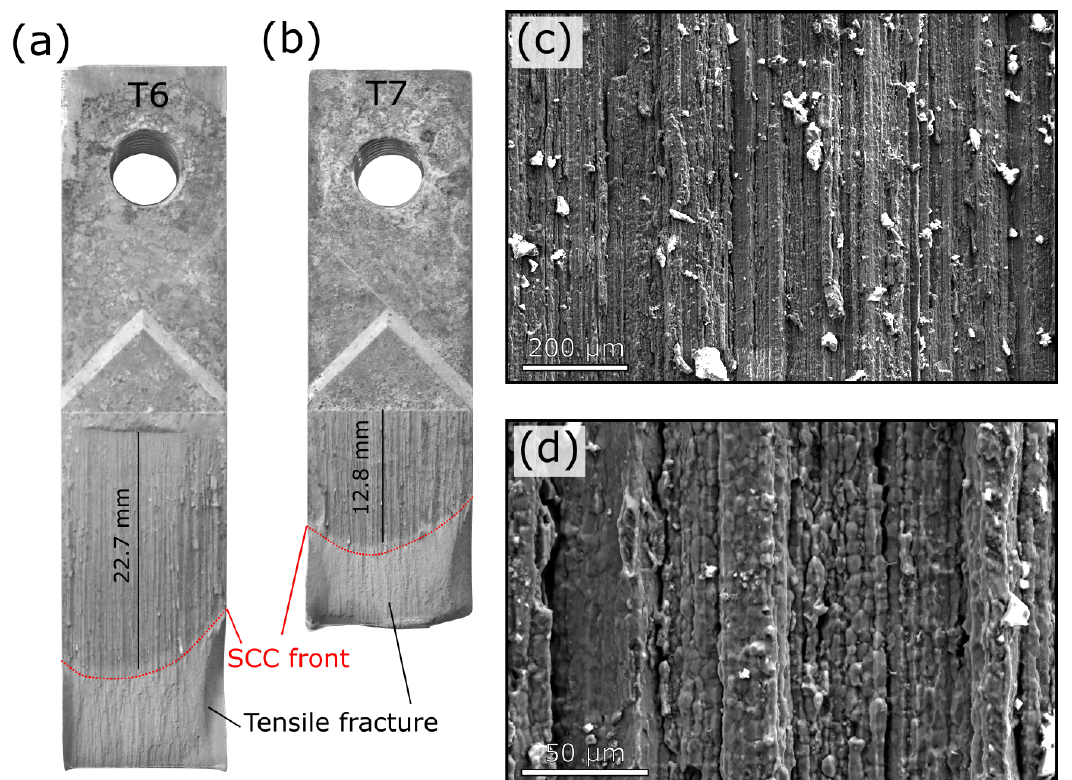
Figure 12. DCB specimens pulled apart using a tensile overload for conditions H-WQ-T6 and H-WQ-T7 in ( a , b ), respectively. ( c , d ) are SE-SEM images aquired at different magnification of the fracture surface within the SCC front area in ( a ).